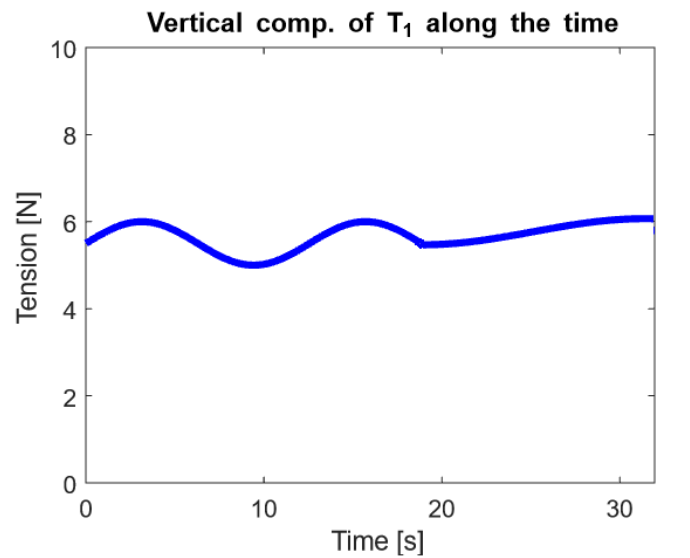
Figure 9. Vertical tension T 1 of the first pendulum under MPC-PD